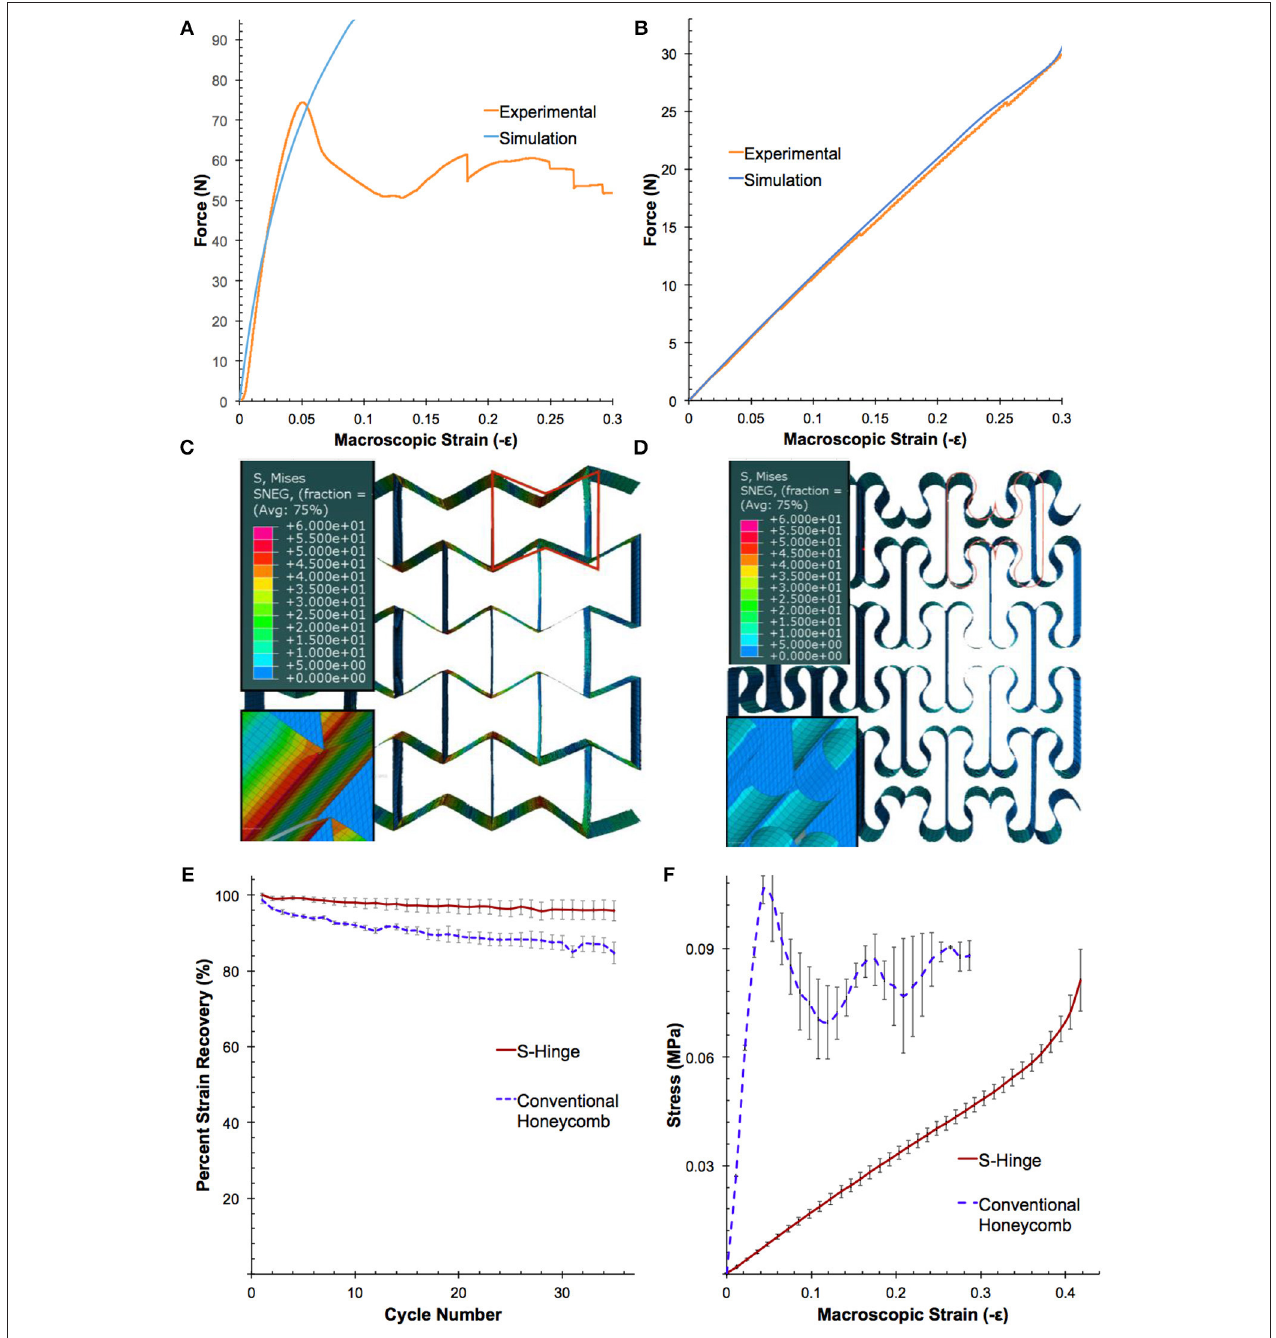
FIGURE 2 | Experimental and FE simulation characterization of conventional honeycomb and s-hinge auxetics. The good agreement of results from the experimental and FE simulations for the (A) conventional honeycomb and (B) s-hinge structures validate the finite element models developed for the structures. The FE simulations are accurate within the elastic region of deformation (local stress < 57.8 MPa). When both structures are deformed elastically to 3% macroscopic strain, finite element analysis demonstrates that stress (color legend numbers in MPa) is (C) unevenly concentrated in the joints of the honeycomb, reaching a maximum of 58 MPa in the corners, and (D) uniformly distributed along the length of the s-hinge at 1 MPa. The orange outline represents the original undeformed cell. (E) Fatigue testing of auxetic materials over 35 cycles of macroscopic 7% strain demonstrates that the s-hinged auxetics have a far greater strain recovery after multiple cycles of loading and unloading compared to the conventional honeycomb structure. (F) Macroscopic strain vs. stress curve for the conventional honeycomb and s-hinge, depicted until the macroscopic strain limit of the s-hinge structure.